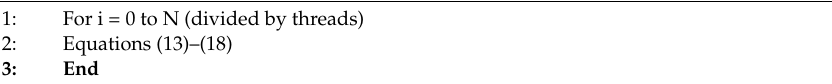
Algorithm 4 GPU parallelisation of ‘Update kinematic state of